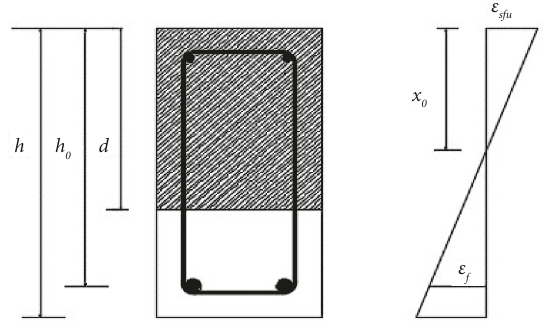
Figure 11: Strain distribution of steel fiber reinforced concrete beams with BFRP bars near cracking